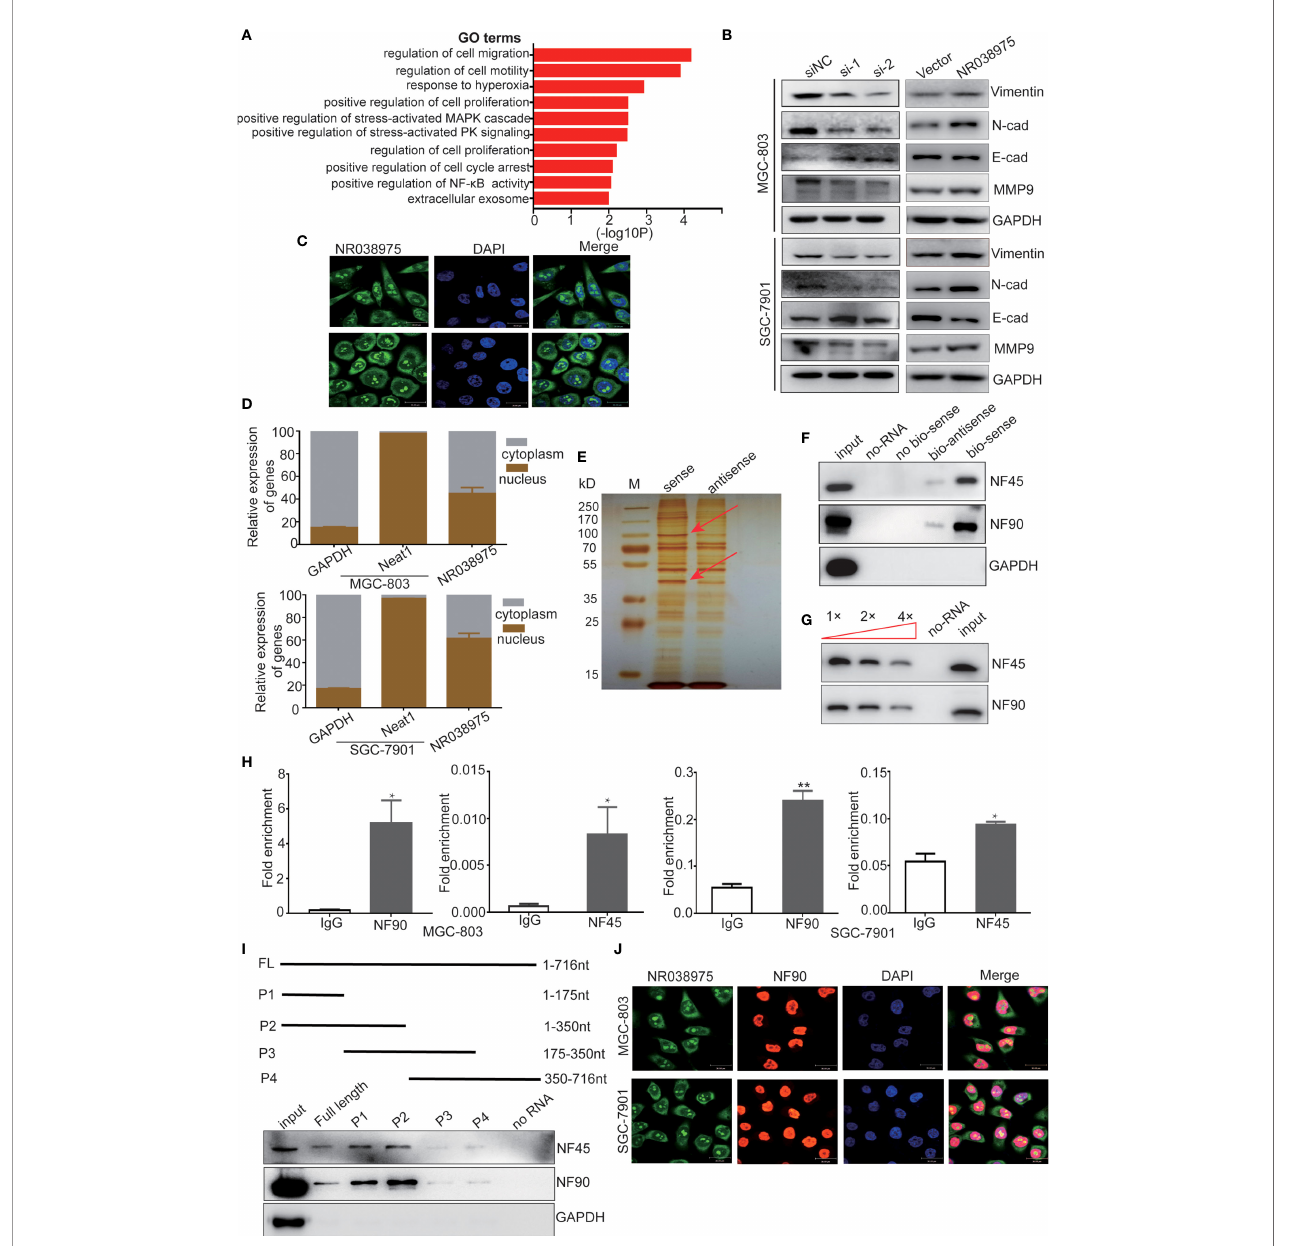
FIGURE 4 | Long noncoding RNA (lncRNA) NR038975 binds to NF90 and NF45. (A) Gene Ontology analysis for all genes with altered expression after knockdown of NR038975. (B) Western blotting analysis of vimentin, N-cadherin, E-cadherin, and matrix metalloproteinase (MMP)9 in NR038975 knockdown and overexpressed gastric cancer (GC) cells. (C) Fluorescence in situ hybridization (FISH) of cells was performed using an NR038975 probe (green). The nuclei were counterstained using 4',6- diamidino-2-phenylindole (DAPI) (blue) (scale bar: 30 m m). (D) Expression levels of NR038975 in cytoplasm and nucleus of GC cells. (E) Silver staining of biotinylated NR038975-associated proteins. Speci fi c bands were excised and analyzed through mass spectrometry. (F) Western blot analysis of the speci fi c association of NF90 and NF45 with NR038975 from RNA pull-down assay. (G) Speci fi c association of NR038975 with NF90 and NF45 proteins is performed by competition assay. Gradient concentrations of unlabeled NR038975 were added to compete with biotin-labeled NR038975 in interacting with NF90 and NF45. (H) RNA immunoprecipitation (RIP) assays were performed using NF90 or NF45 antibodies. Speci fi c primers were used to detect NR038975, and RIP enrichment was determined relative to an input control. (I) Schematics of the full-length and deletion fragments of NR038975 used for the precipitation of NF90 and NF45 from MGC-803 cell lysates. Associated NF90 and NF45 proteins were detected by Western blotting. (J) MGC-803 and SGC-7901 cells were seeded on glass coverslips in 24-well plates and then fi xed with 4% paraformaldehyde. NR038975 probes (green) and a fl uorescence-conjugated antibody against NF90 (red) were used for combined application of RNA-FISH and immuno fl uorescence. Cell nucleus was stained with DAPI (blue). *p < 0.05, **p <